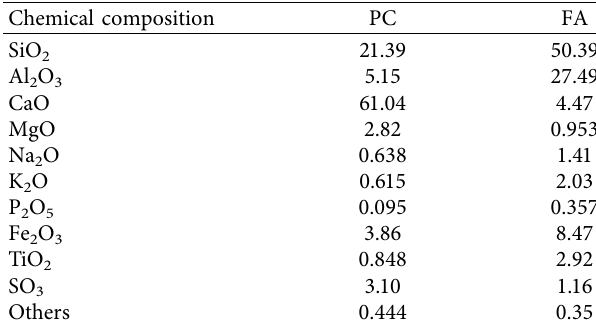
Table 1: The chemical composition of cementitious materials